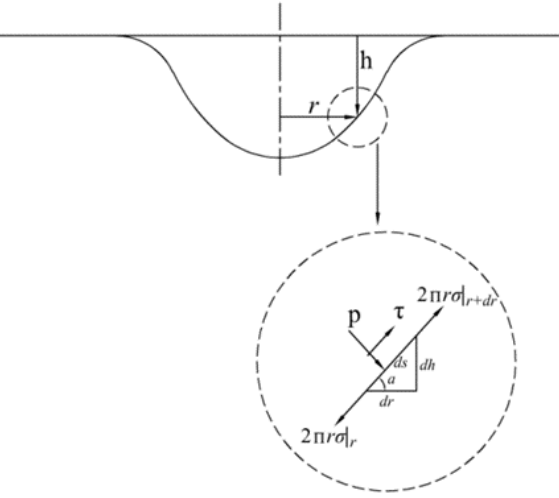
Figure 1. Diagram of the mechanical equilibrium on the surface formed by the gas jet.